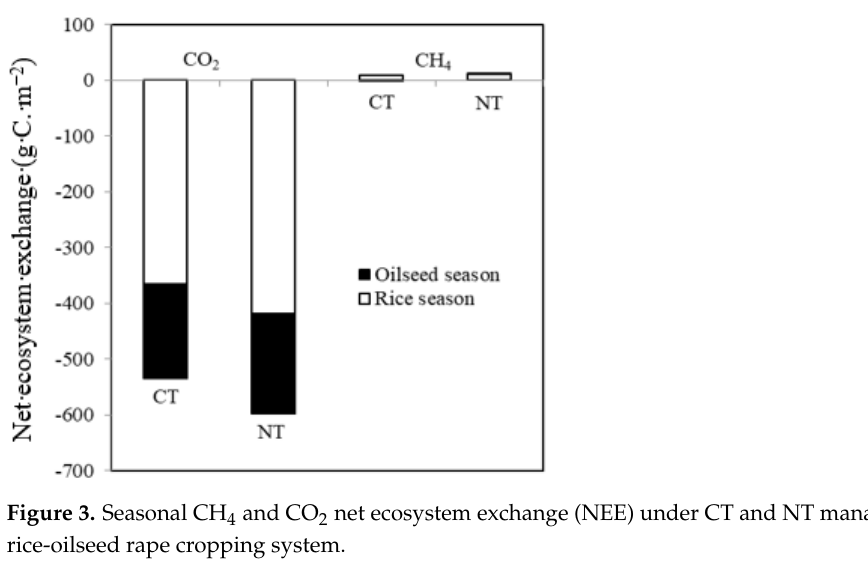
Figure 2. Changes in daily CO 2 ( a ) and CH 4 ( b ) net ecosystem exchange (NEE) under conventional tillage (CT) and no-tillage (NT) management in a rice–oilseed rape cropping system. The bars mean the standard error.